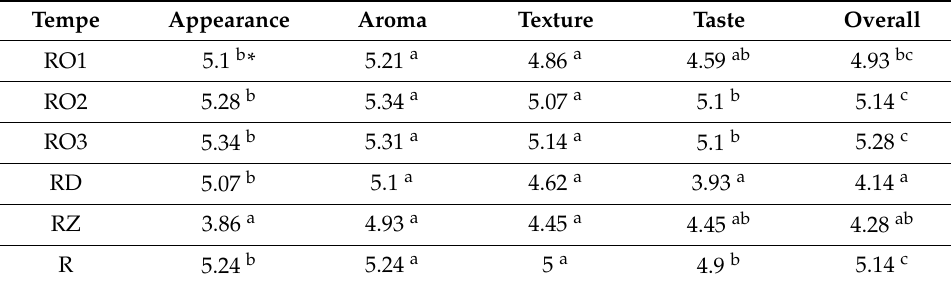
Table 3. Sensory evaluation of soybeans fermented using various Rhizopus strains.